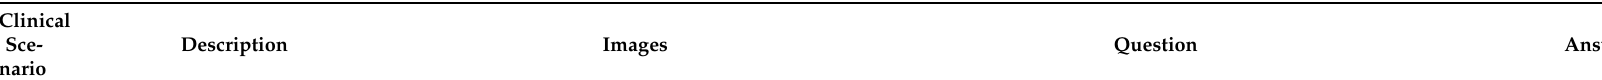
Table 1. Clinical scenarios and references from the scientific evidence consulted for each